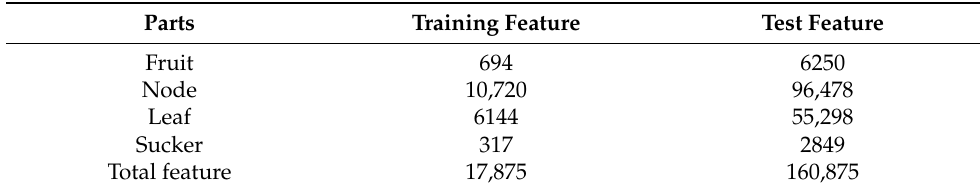
Table 6. Number of features used for learning.